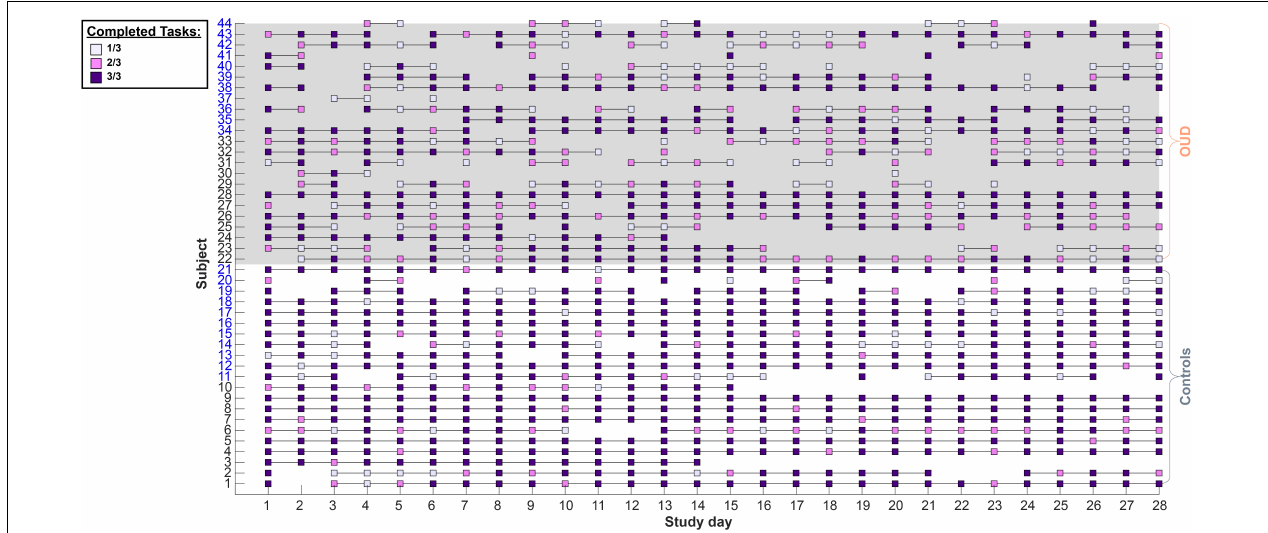
FIGURE 2 | Study compliance with task prompts. Subjects completed up to three decision-making tasks daily. Each square denotes at least one completed task per day. Lines connect successive days that a subject had completed at least one task. Subject numbers on the y axis in black denote cohort 1 while blue denotes cohort 2. In cohort 1, the three tasks (risk in gains, risk in losses, and intertemporal choice) were administered as three separate prompts while in cohort 2 these were administered as two prompts (grouping the gain and loss risk tasks in one prompt). Overall, subjects maintained a moderate (66.88%) compliance rate with controls tending to be more compliant than patients (see section